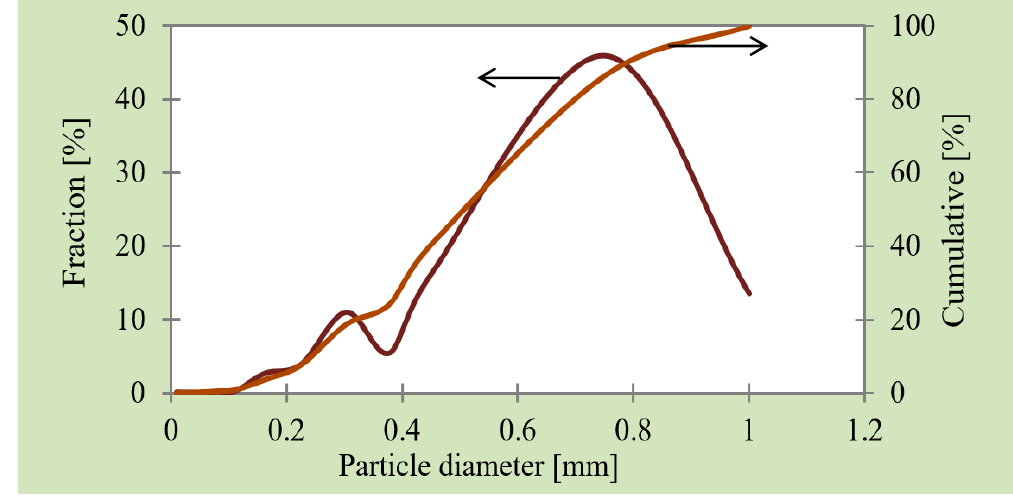
Figure 5. The particle size distribution of biomass.